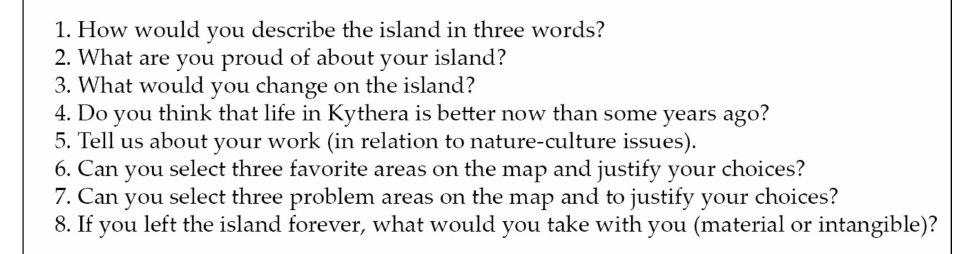
Figure 8. The questions of the constructed interviews with the residents of Kythera presented in the MedINA INCREAte project